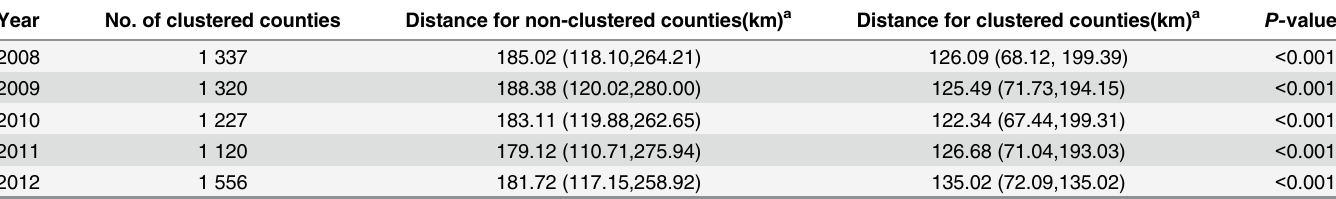
Table 3. Distance from the provincial capital city of clustered counties and non-clustered counties, 2008 – 2012.